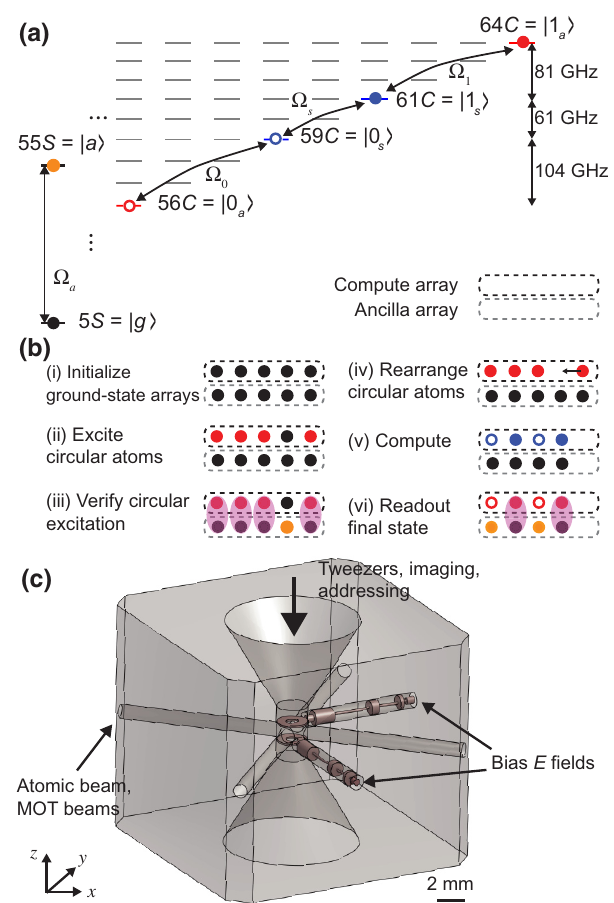
FIG. 1. (a) Relevant energy levels and transitions for imple- mentation with Rb. nC denotes the circular state with principal quantum number n , while nS is the corresponding S 1 / 2 state (5 S is the ground state). (b) Schematic diagram of the proposed exper- imental sequence (Sec. I). Each circle represents a single atom, with a state color-coded following part (a). (c) Schematic dia- gram of microwave waveguide used to enhance the circular-atom lifetime. The vertical bore ( D = 2.2 mm in the center) provides optical access with NA = 0.5 for tweezers and for imaging and addressing beams, while the side bores allow atoms, cooling light for the magneto-optical trap (MOT), and lattice beams into the structure. Electrodes apply a uniform electric field along ˆ z , and are biased via a reflective stepped-impedance low-pass filter.